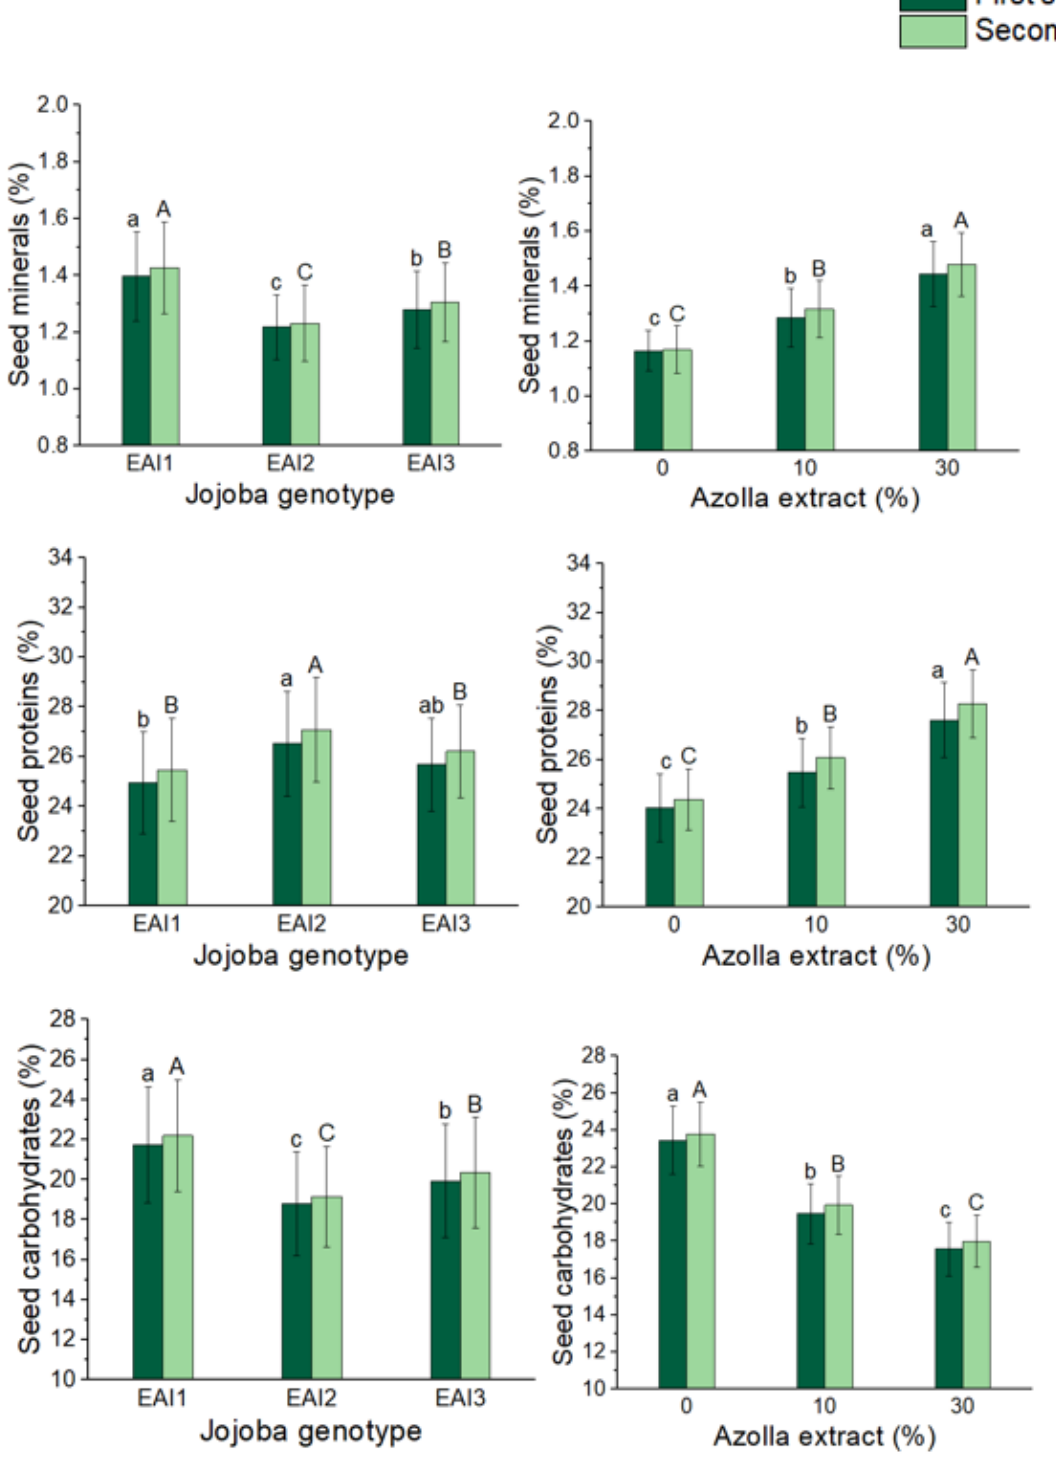
Figure 4. In both seasons, the mean values of minerals (%), proteins (%), and carbohydrates (%) of jojoba shrubs were modified by plant genotypes and foliar application of Azolla filiculoides Lam. plant extract respectively. The data are expressed as a mean value ± SE. At the 0.05 level, bars with identical letters are not significant.